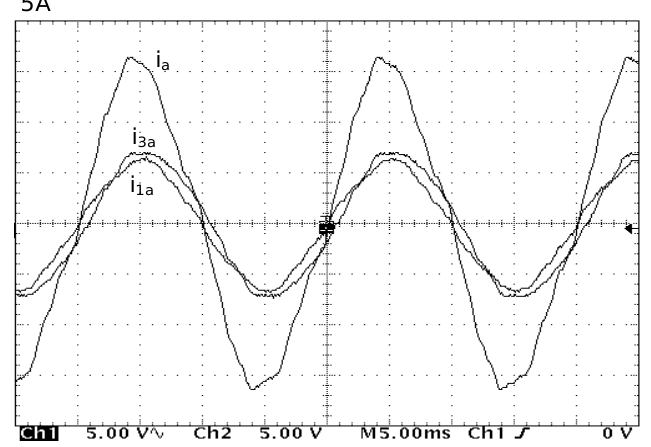
Figure 22. Oscillograms: Line voltage u a and current i a waveforms of the 2 kW rectifier.